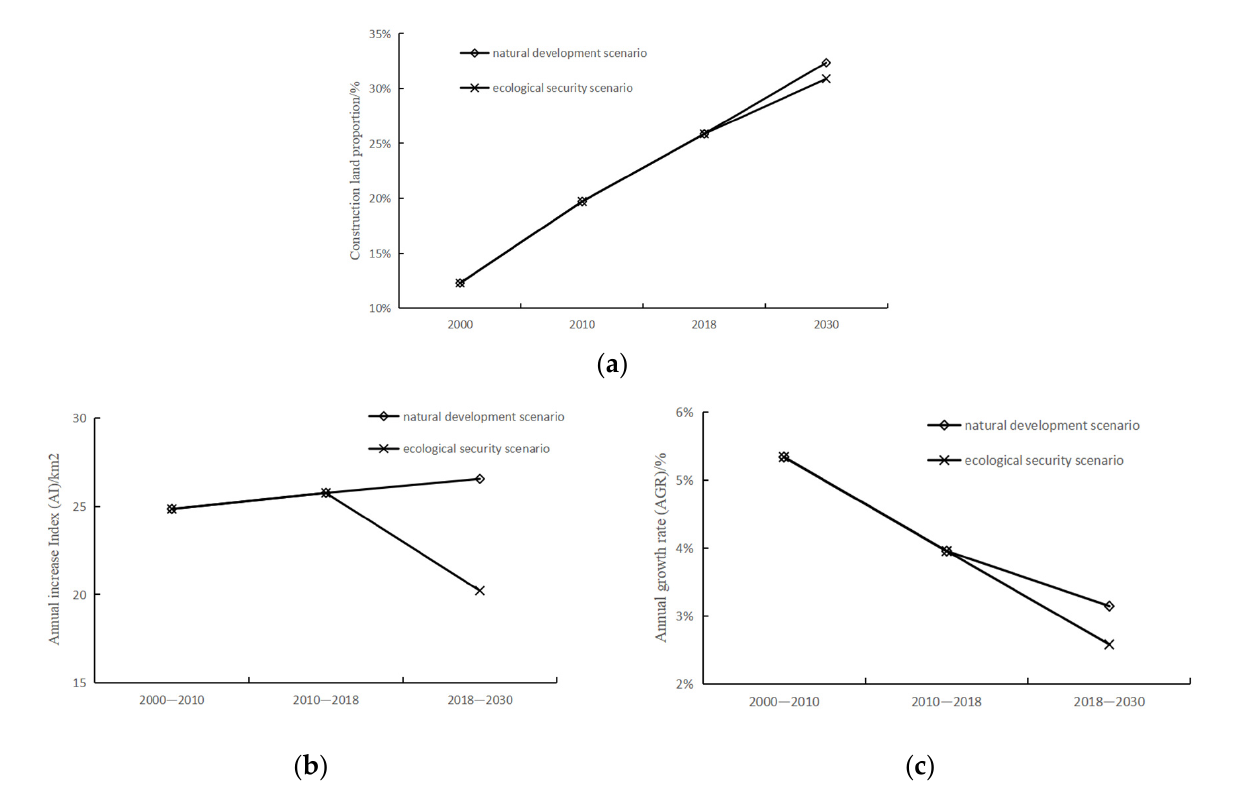
Figure 8. Characteristics of urban expansion from 2000–2030: ( a ) construction land area proportion; ( b ) annual increase index (AI); ( c ) annual growth rate (AGR).